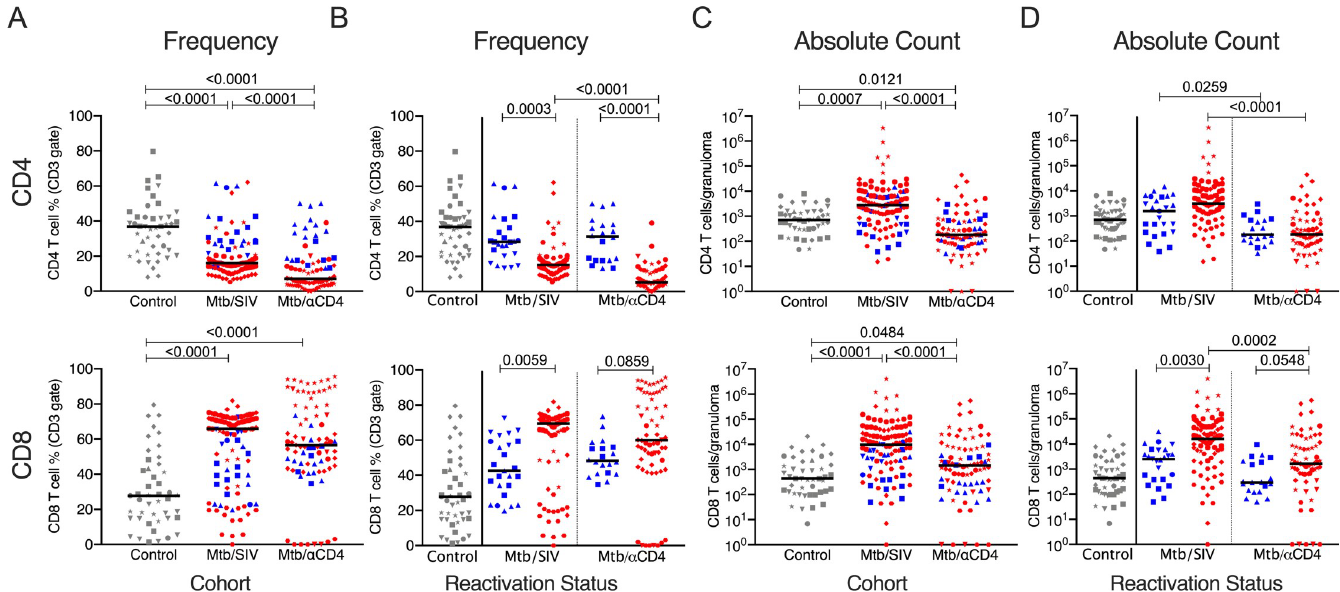
Fig 4. Frequencies of CD4 T cells are severely reduced by CD4 depletion but SIV markedly increases the total number of T cells within granulomas. Non- reactivators (blue) and reactivators (red) from Mtb only (control, grey), Mtb/SIV co-infected, and CD4 depletion (Mtb/ α CD4) NHP are shown. A) and B) CD4 and CD8 T cell frequencies from lung granulomas (individual symbol) within individual monkeys (shapes) are shown. C) and D) Total number of CD4 and CD8 T cells within the granuloma are shown. Kruskal-Wallis test with Dunn’s multiple comparisons adjusted p-values are shown. P-values < 0.10 are shown. Lines represent medians. (6 Mtb control, n = 46 granulomas; 8 Mtb/SIV NHP, n = 110; and 7 Mtb/ α CD4 NHP, n = 86; within Mtb/SIV NHP, non-reactivators = 25 granulomas, reactivators = 85; and within Mtb/ α CD4 non-reactivators = 20, reactivators =